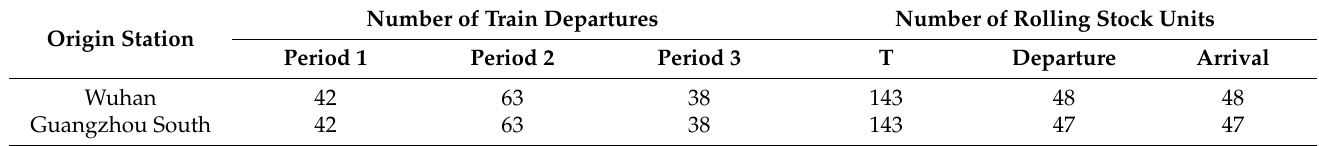
Table 11. Time-space distribution of trains and rolling stock